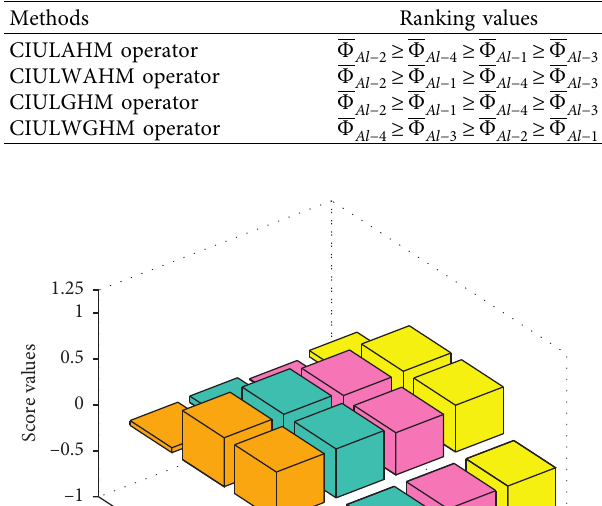
Table 17: Ordering of the given alternatives.